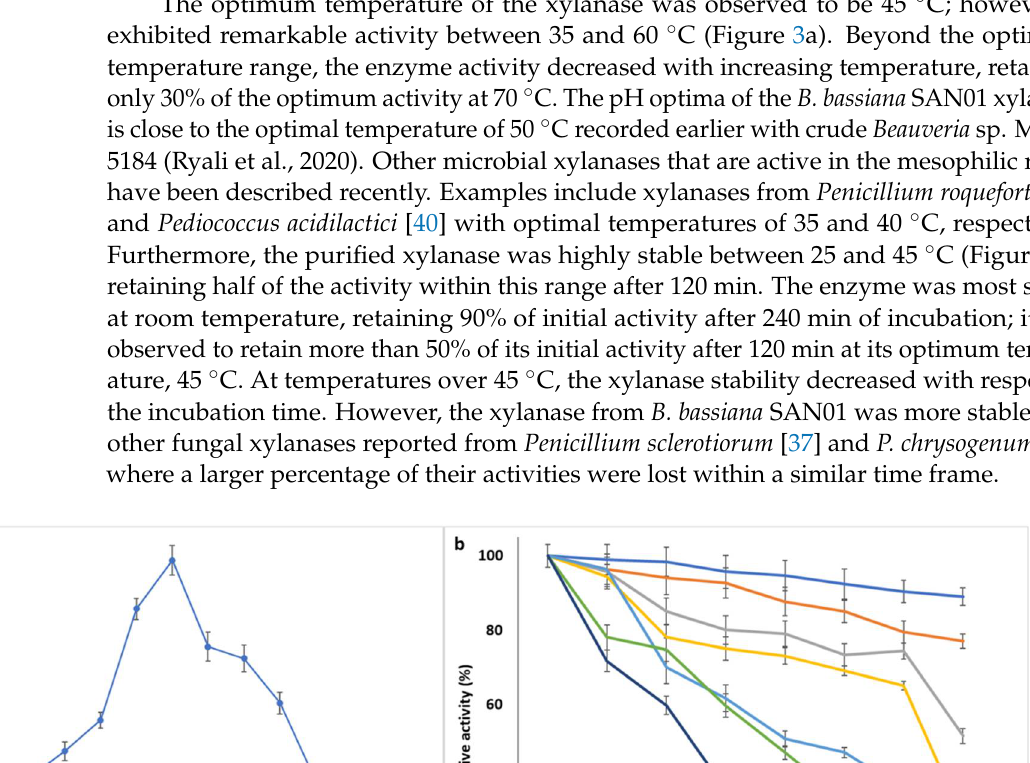
Figure 2. ( a ) Effect of pH on the activity of Beauveria bassiana SAN01 xylanase; ( b ) Effect of pH on the stability of Beauveria bassiana SAN01 xylanase; each point represents the mean ( n = 3) ± SD.